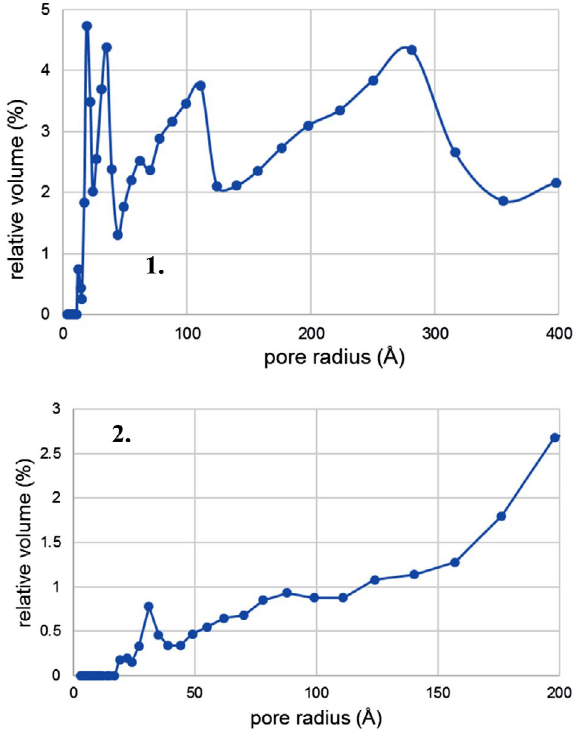
Figure 2. Pore size distribution (1) control (2) dye adsorbed cal- cined